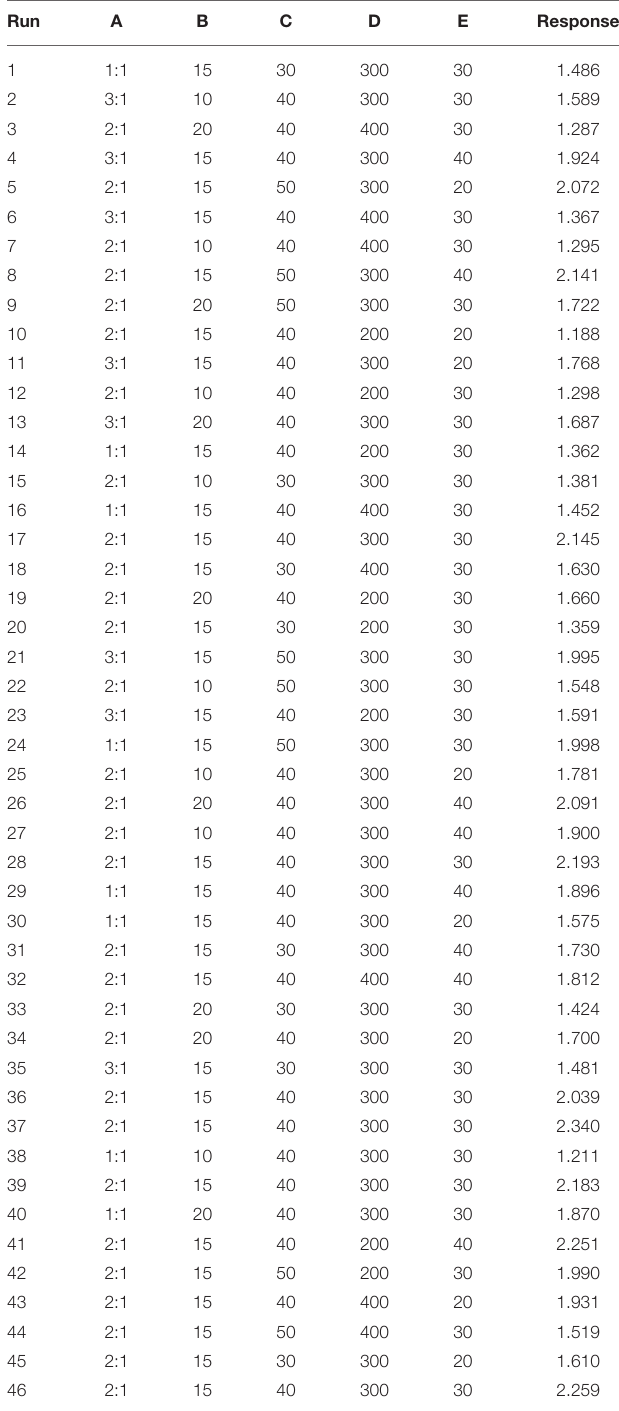
TABLE 1 | Box-behnken design (BBD) matrix with response values for the xylose